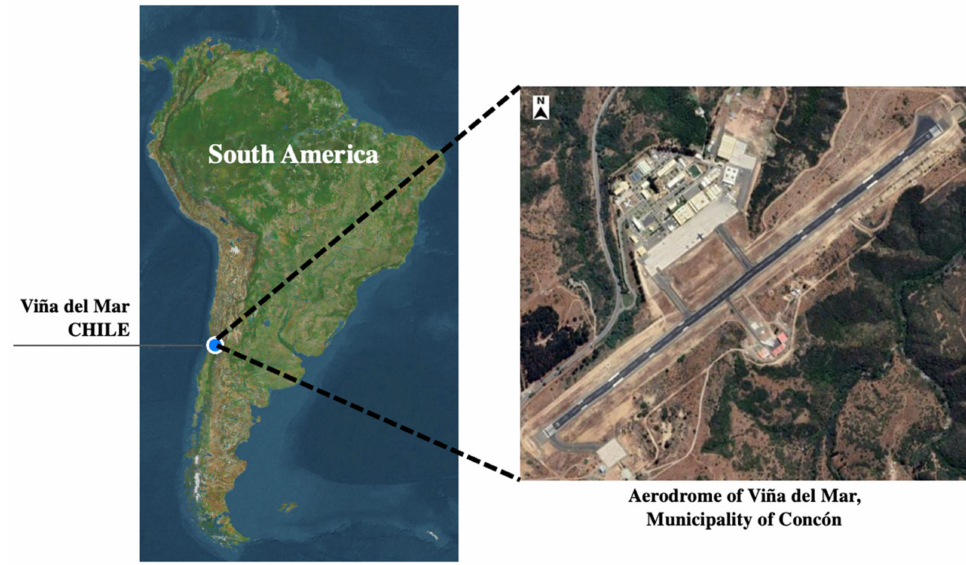
Figure 1. Location of Viña del Mar airport (Valpara í so region, Central